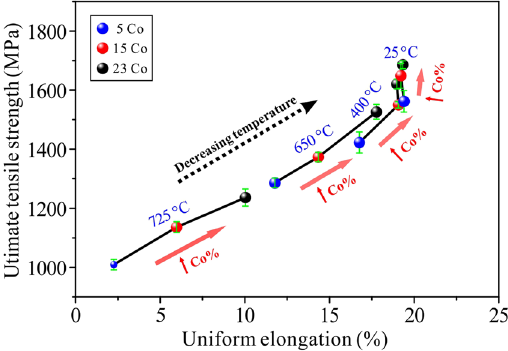
Figure 3. The SISP tendency of three alloys with the decrease of temperature. It shows that adding Co mainly leads to the increase of UTS at 25 and 400 °C, while it can introduce an obvious SISP in the superalloys at 650 and 725